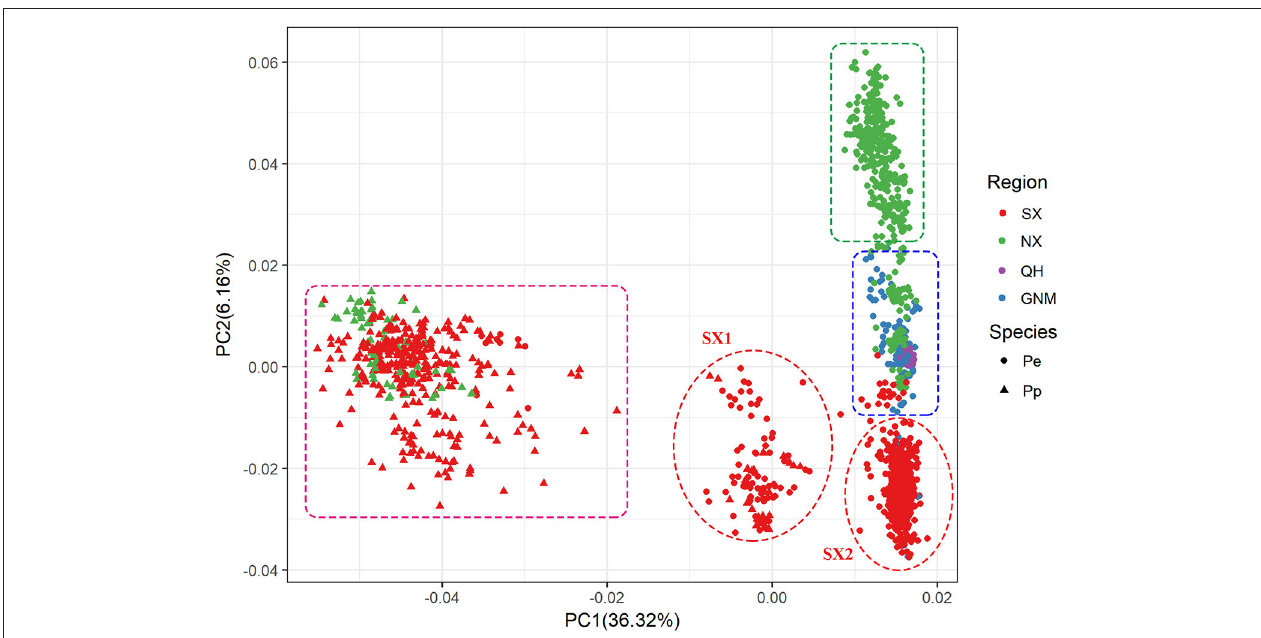
FIGURE 3 | PCA based on genetic distance showing four clustered subpopulations within P. euphratica and P. pruinosa .